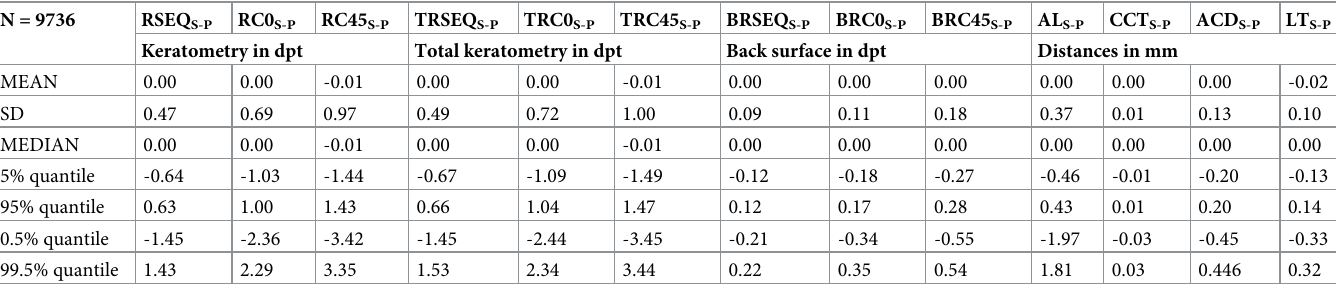
Table 2. Explorative data of the difference between secondary and primary eye (S-P) extracted from the dataset of the IOLMaster 700 biometer. N =